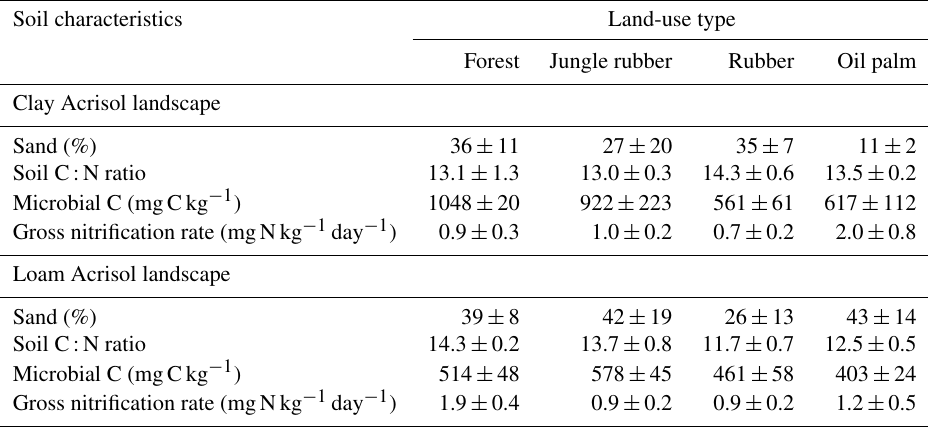
Table A2. Mean ( ± SE, n = 4 sites) soil physical and biochemical characteristics in the top 0.10m depth (except sand content with n = 3 sites) from different land uses within each landscape in Jambi, Sumatra, Indonesia. These soil factors and the gross nitrification rates were reported by Allen et al. (2015).